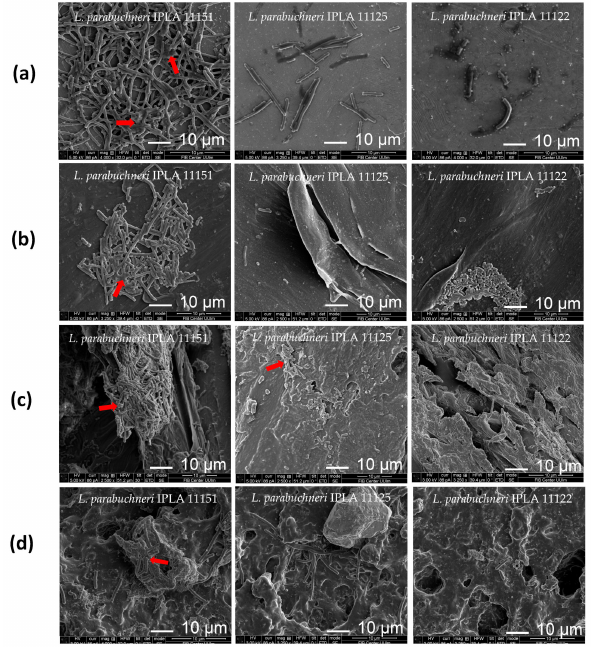
Figure 8. Scanning electron microscopy images of L. parabuchneri strain biofilms grown at 37 ◦ C for 48 h on different surfaces: ( a ) stainless steel; ( b ) food-grade plastic; ( c ) beech wood; and ( d ) rubber. Scale bars (10 µ m) are shown on the photomicrographs. Red arrows indicate extracellular polymeric substances in the